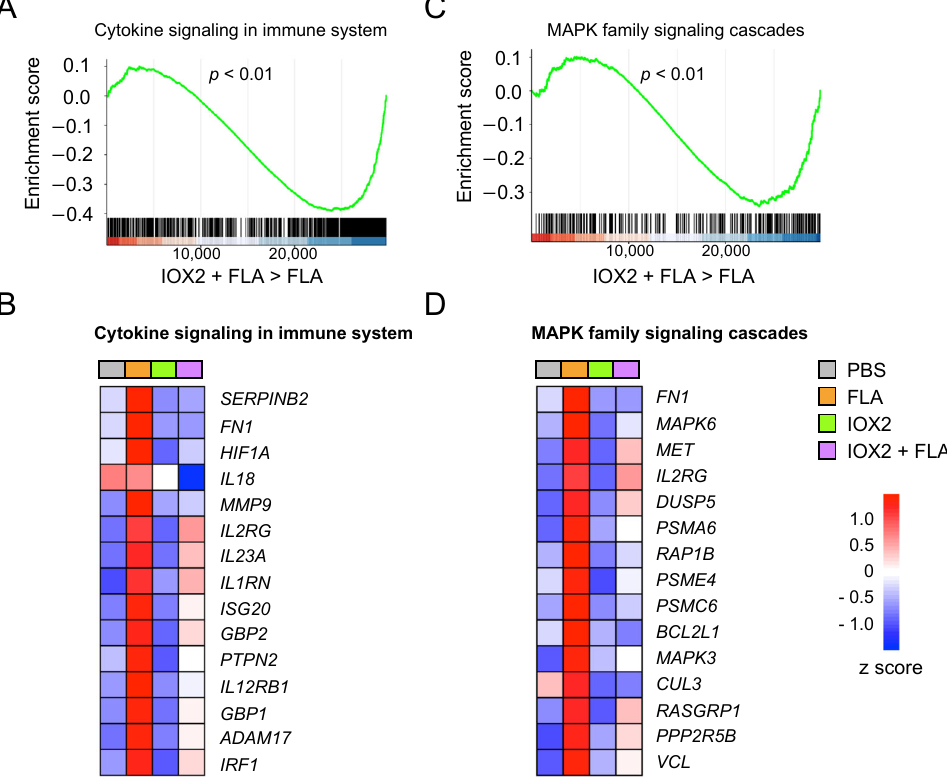
Figure 3. IOX2 inhibits immune signaling pathways in HBE cells. ( A ) Gene set enrichment analysis (GSEA) of the “cytokine signaling in immune system” pathway (R ‐ HAS ‐ 1280215.5 in https://reactome.org, accessed on 8 September 2021) in HBE cells activated with flagellin or PBS for 24 h in the presence of either vehicle or 50 μ M IOX2 (pre ‐ treated for 1 h). ( B ) Heat ‐ map of changes in the expression of the “cytokine signaling in immune system” pathway genes in the indicated conditions. ( C ) GSEA of the “MAPK family signaling cascades” pathway (R ‐ HAS ‐ 5683057 in https://reactome.org, accessed on 8 September 2021) in HBE cells from ( A ). ( D ) Heat map of changes in the expression of the “MAPK family signaling cascades” pathway genes in HBE cells from ( A ). Data in ( A – D ) comprise 3 biological donors with 1–2 replicates from 2 independent experiments ( n = 5). Red represents upregulated genes and blue represents downregulated genes. In ( A , C ), Log2 ‐ fold expression values were ranked in descending order. The x axis shows individual genes and the y axis shows enrichment score.